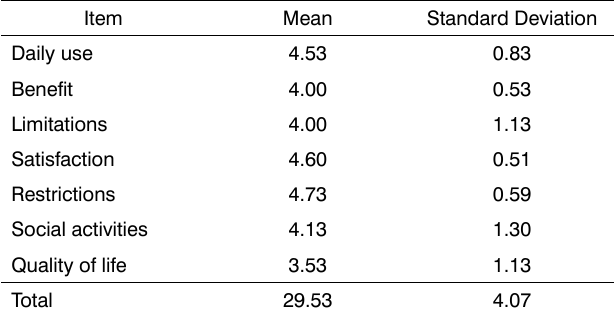
Table 1. Distribution of the answers in each domain of the IOI-HA instrument.